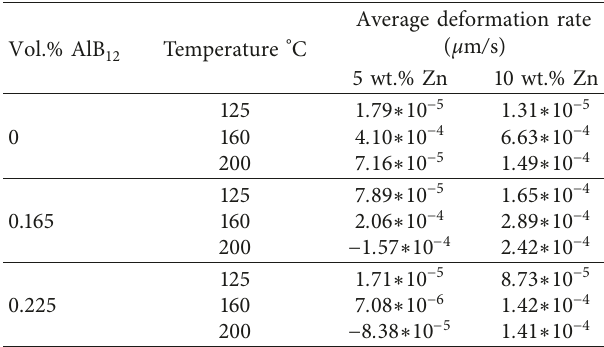
, circles � 16.5 vol.% AlB , and squares � 22.5 vol.% AlB ). 12 12 12 Table 3: Deformation rate for the samples bearing 5 wt.% Zn and 10 wt.%